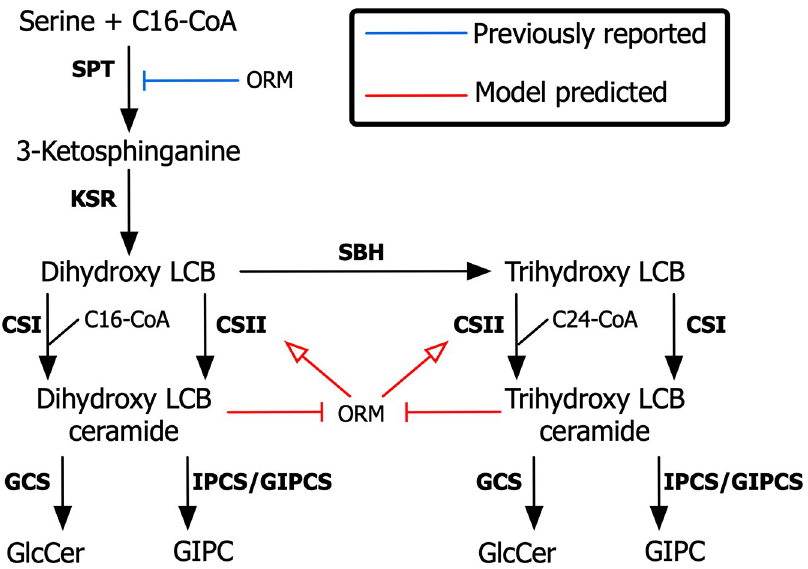
Fig 4. Predicted regulatory scheme of the sphingolipid pathway. A metabolic and regulatory network displaying the mechanism predicted to be responsible for the emerging observed behavior of the pathway. Ceramides repress ORM- mediated activation of CSII. Blue lines indicate regulatory interactions identified in previous studies and red lines indicate novel interactions predicted in this study.